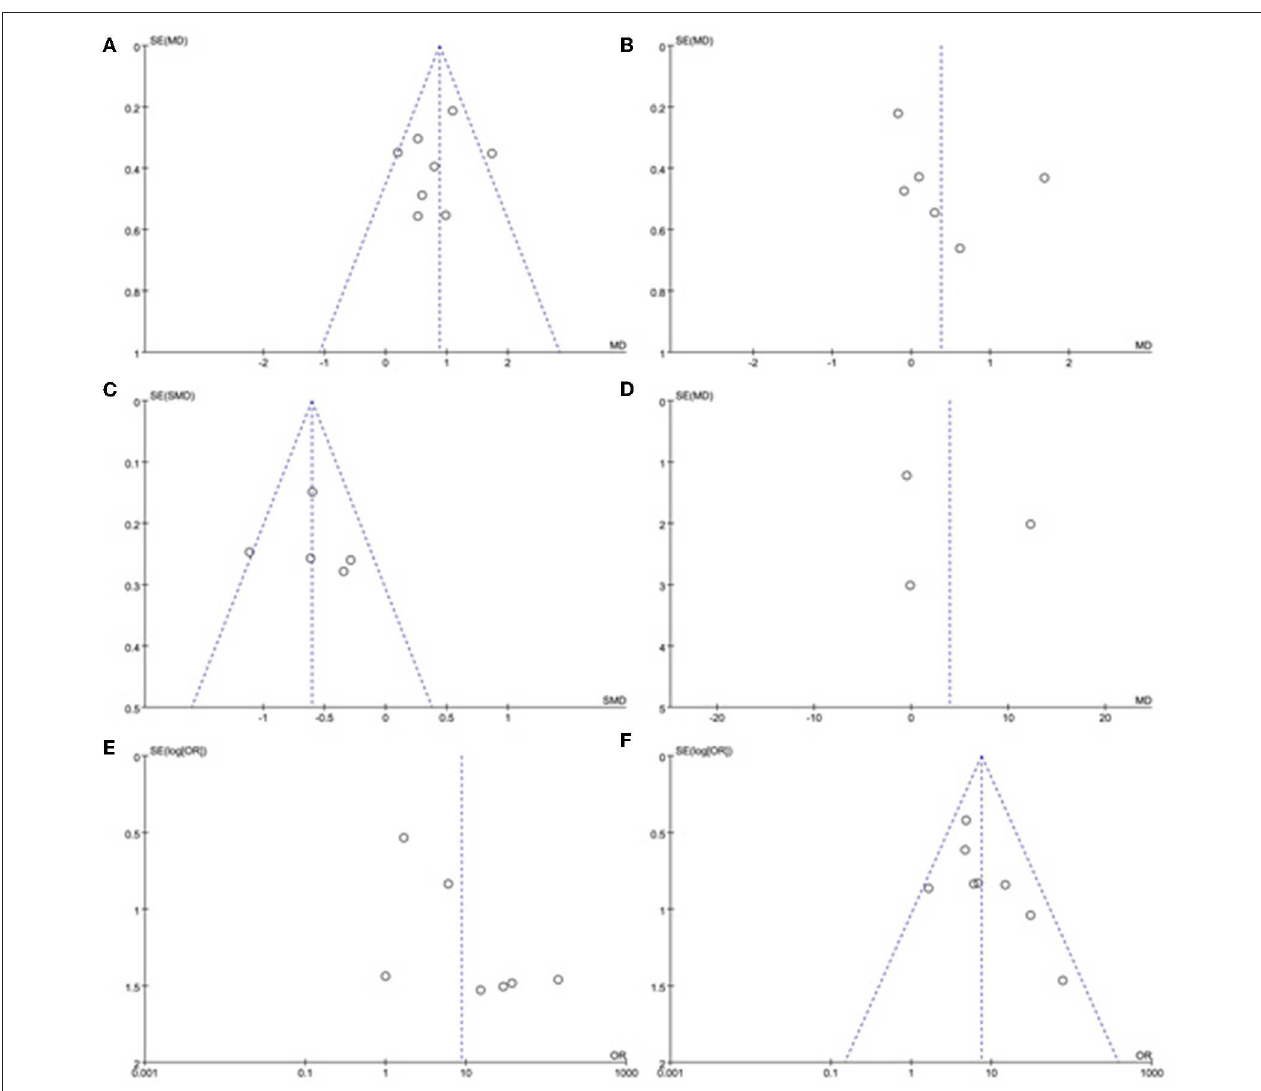
FIGURE 10 | Funnel plots for the evaluation of publication bias in the selected studies. (A) Funnel plots of p13 latency of cVEMP. (B) Funnel plots of n23 latency of cVEMP. (C) Funnel plots of amplitude of cVEMP. (D) Funnel plots of p13 asymmetry ratio of cVEMP. (E) Funnel plots of proportion of absent response of cVEMP. (F) Funnel plots of proportion of abnormal cVEMP. BPPV, benign paroxysmal positional vertigo; cVEMP, cervical vestibular evoked myogenic